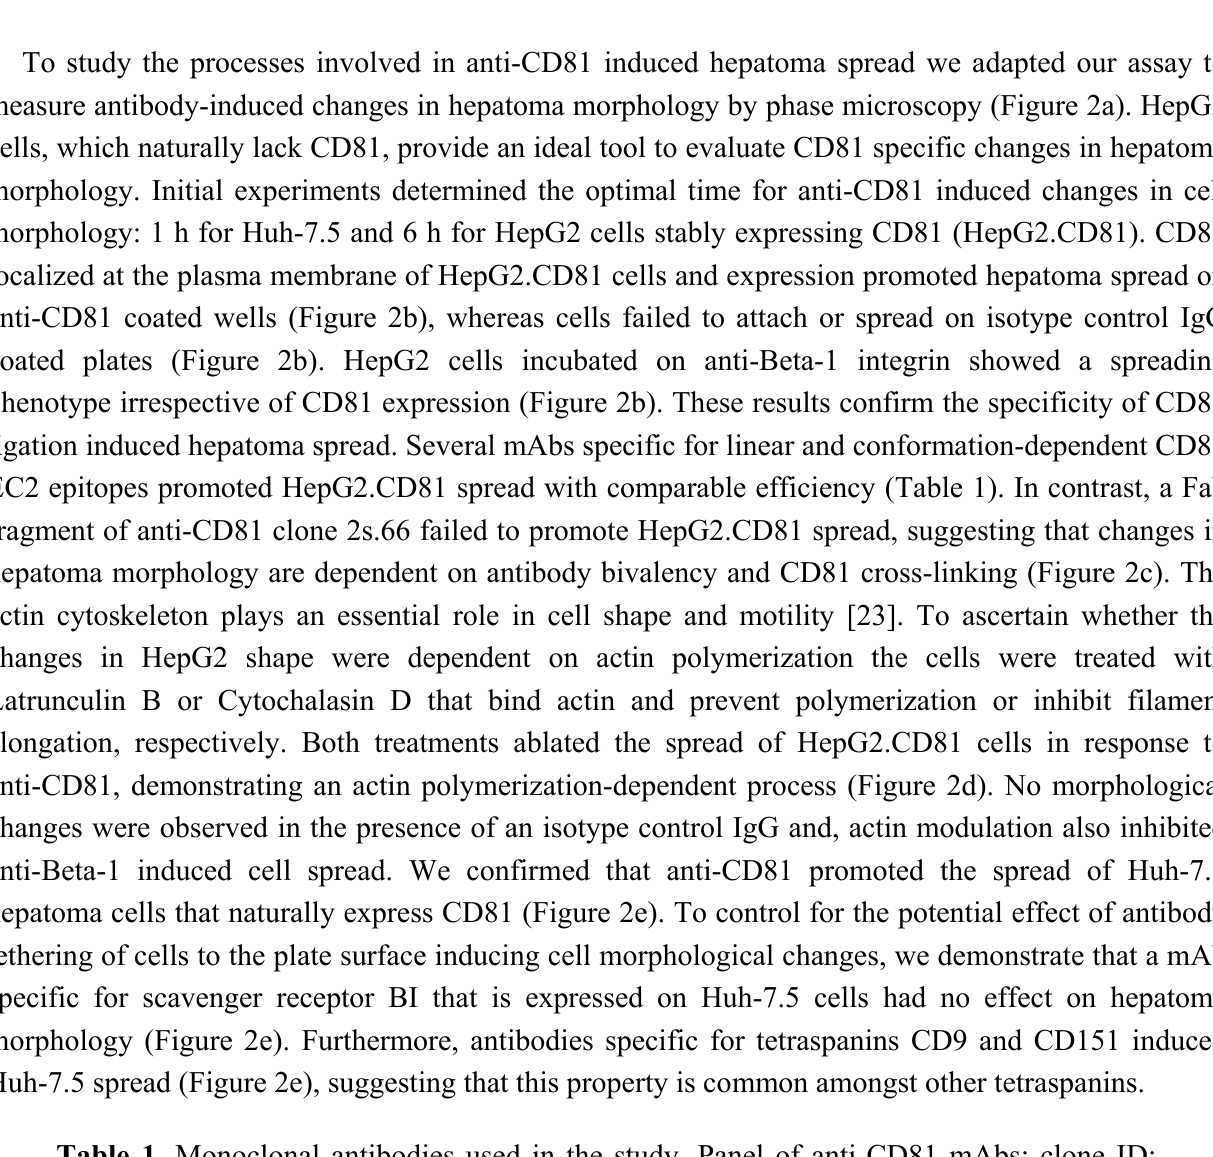
Table 1. Monoclonal antibodies used in the study. Panel of anti-CD81 mAbs: clone ID; recognition of linear peptide epitope (NLCPSGSNIISNLFKEDCHQ); binding to HepG2.CD81 cells; cell spread in HepG2.CD81